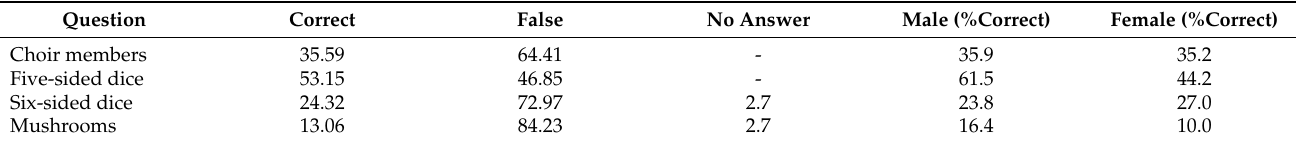
Table A5. Berlin Numeracy Test per answer (%).